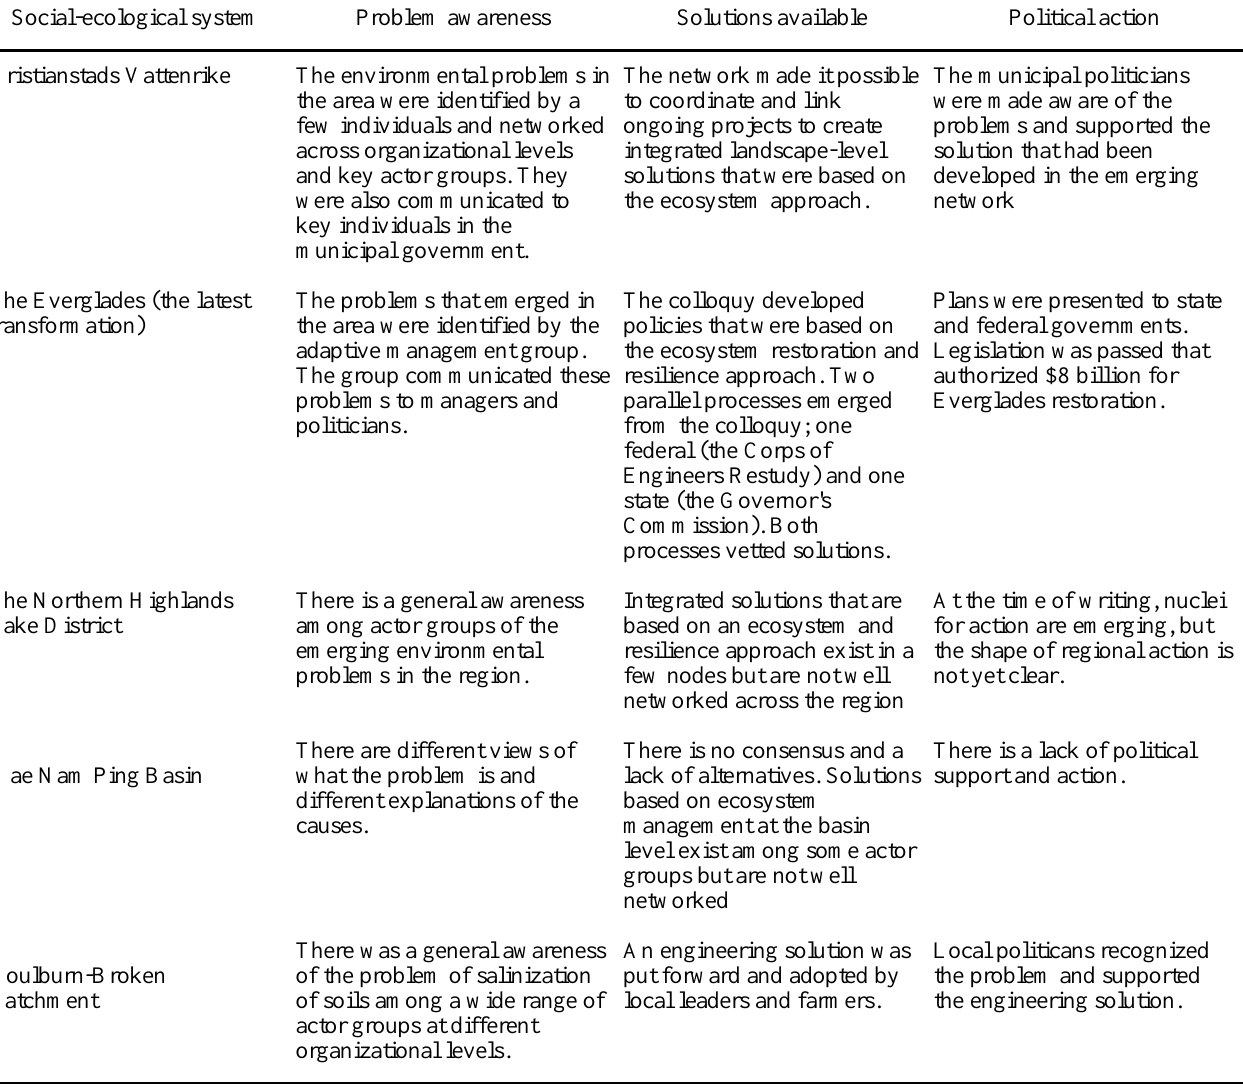
Table 2 . Comparing the five case studies regarding windows of opportunity for change and the attributes of the three streams identified by Kingdon